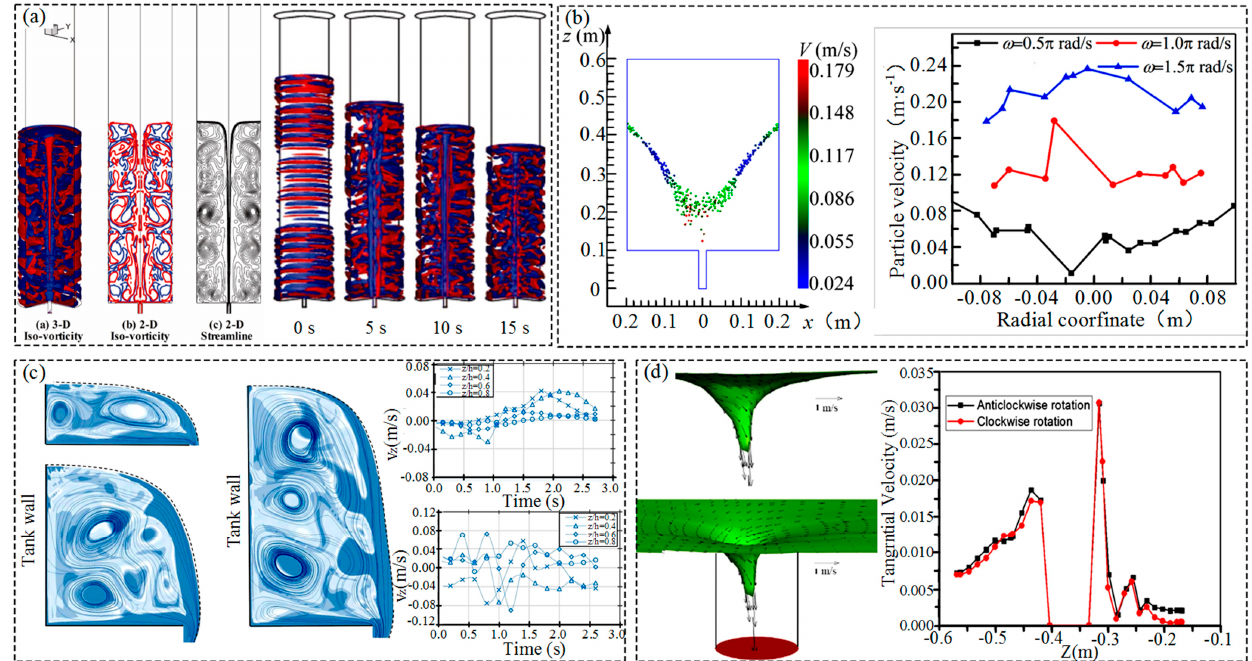
Figure 8. Flow patterns of the surface vortex [66–68,75]. ( a ) Vorticity distribution. (Reprinted with permission from Ref. [68]. 2015, Springer Nature). ( b ) Particle velocity. (Reprinted with permission from Ref. [75]. 2019, Elsevier). ( c ) Flow field streamlines. (Reprinted with permission from Ref. [67]. 2018, Springer Nature). ( d ) Flow patterns with a different rotation. (Reprinted with permission from Ref. [66]. 2020, Springer Nature).